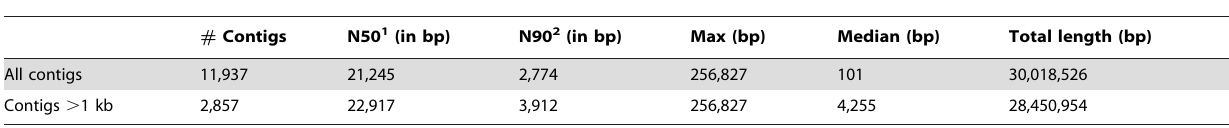
Table 1. De novo assembly summary statistics.